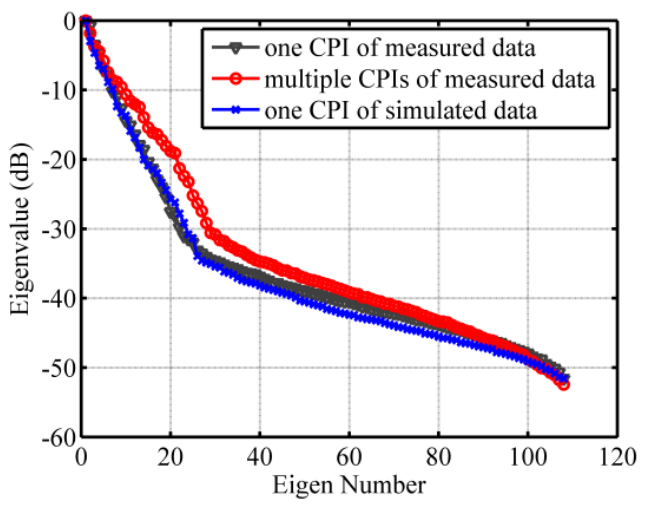
Figure 8. Eigenvalue spectrum.